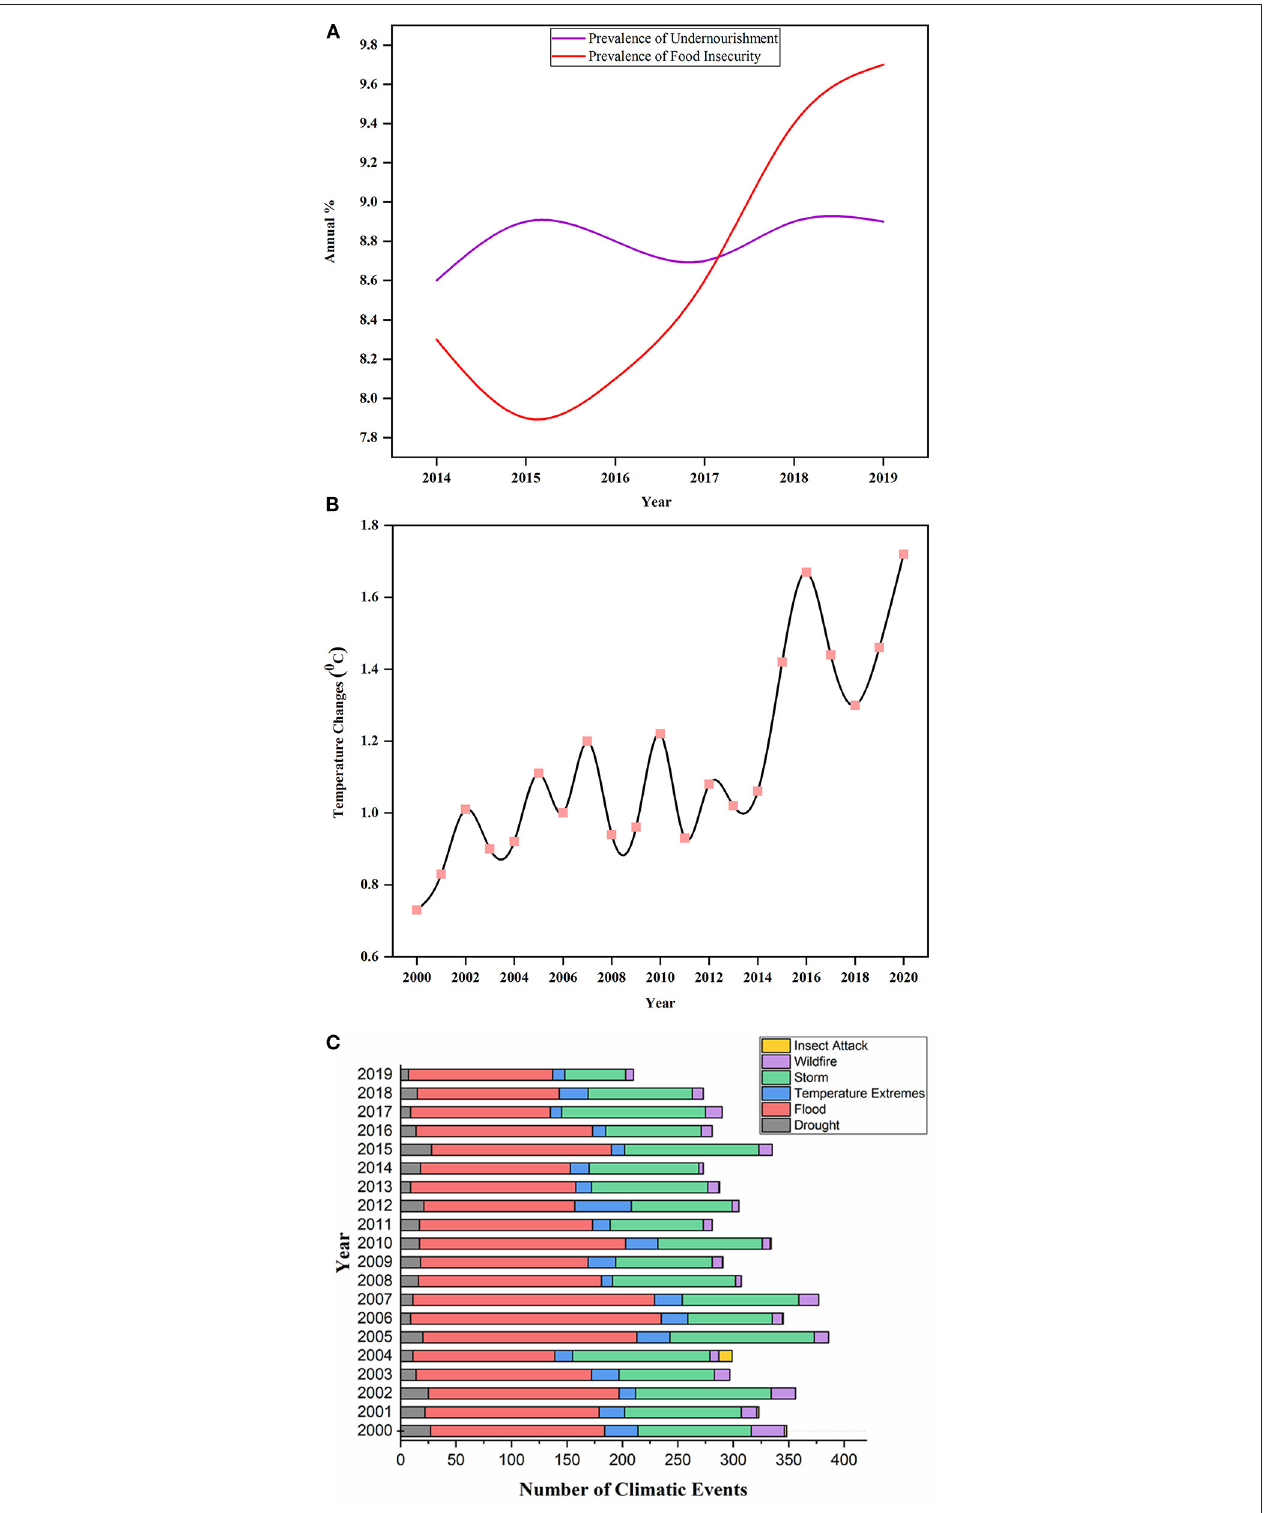
FIGURE 1 | Displaying the annual prevalence of undernourishment and food insecurity percentage during 2014–2019 in (A) . Source: Food and Agriculture Organization (FAO) (http://www.fao.org/faostat/en/#data/FS/visualize). Illustration of changing trends in the world’s temperature annually from 2000 to 2020 in (B) . Source: FAO (http://www.fao.org/home/en/). (C) depicted the total number of climatic events that occurred from 2000 to 2020 around the world. The climatic events include drought, extreme temperature, flood, storm, wildfire, and insect attack. Source: Emergency Disaster Database 2 .